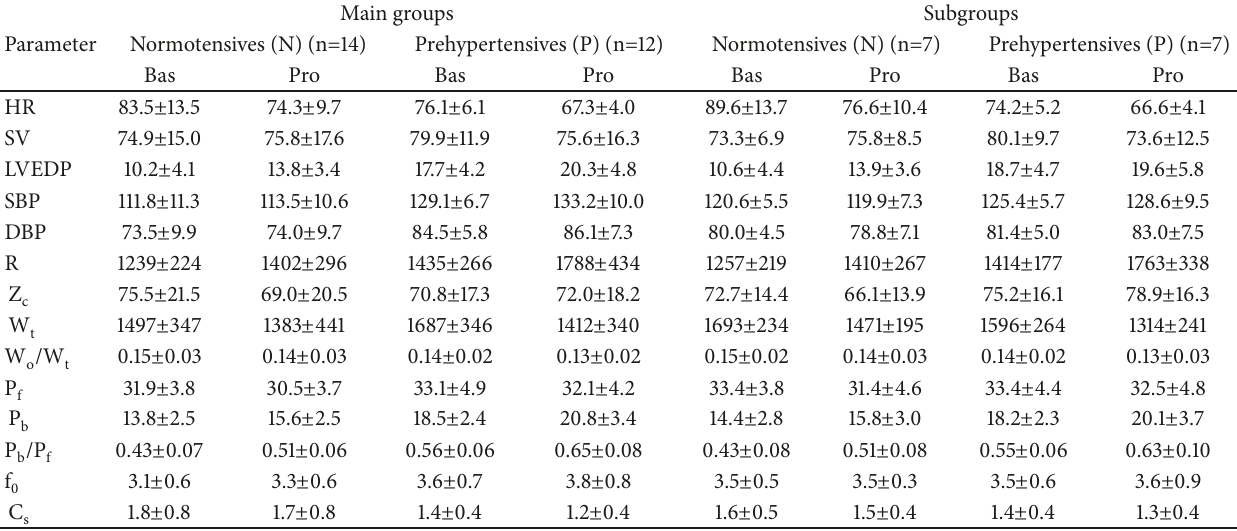
Table 2: Baseline (Bas) and after-propranolol (Pro) hemodynamic parameters (mean ± SD) in the main groups and the subgroups.